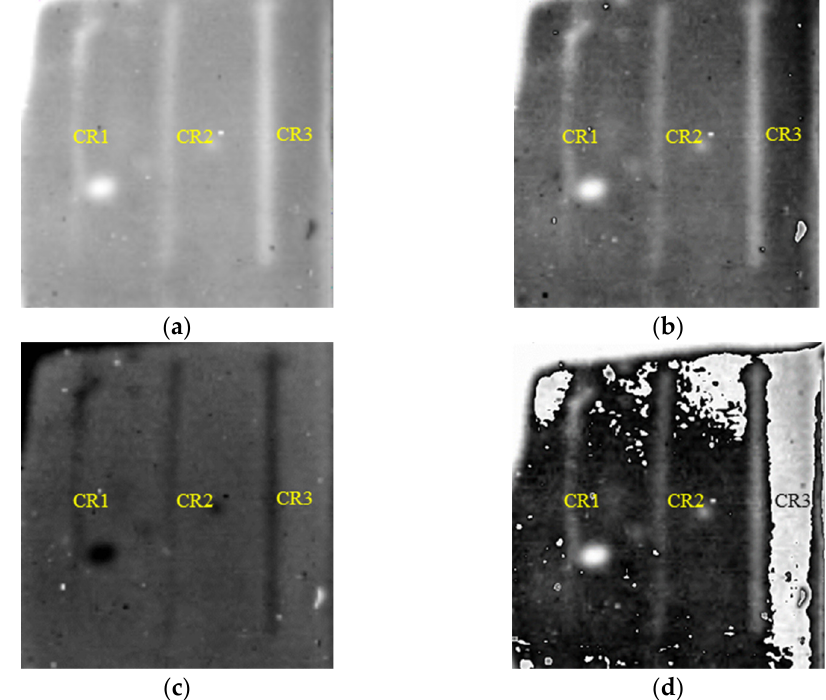
Figure 10. Detection results of cracks in FRP bonded with 3 mm thick SIR. ( a ) The 1570th frame 1st DTI. ( b ) The 1479th frame 2nd DTI. ( c ) The 2487th frame 2nd DTI. ( d ) FDTI from subtracting 2nd DTIs.